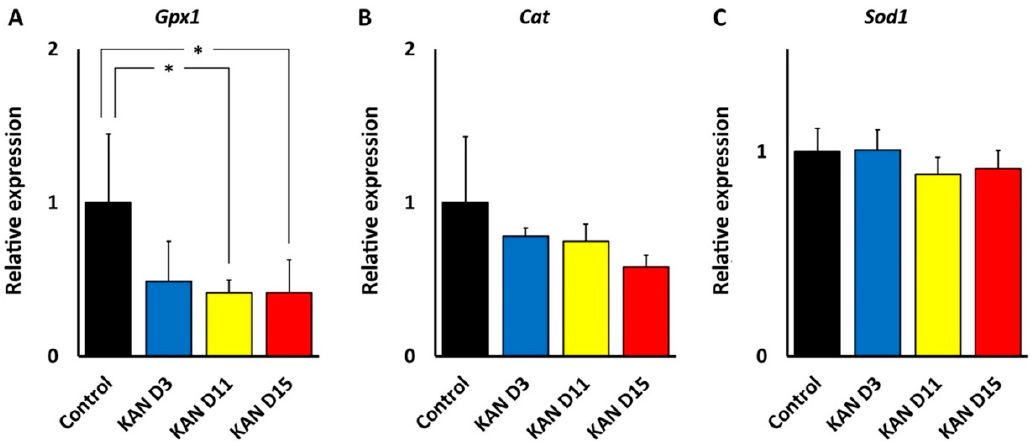
Figure 8. Changes in the expression of antioxidant enzyme genes in the cochlea after treatment with kanamycin (KAN). Relative expression level of the Gpx1 ( A ), Cat ( B ) and Sod1 ( C ) genes under conditions of kanamycin ototoxicity at D3, D11 and D15. See text for details. Asterisks indicate statistical significance values, as specified in Section 2.6, Materials and